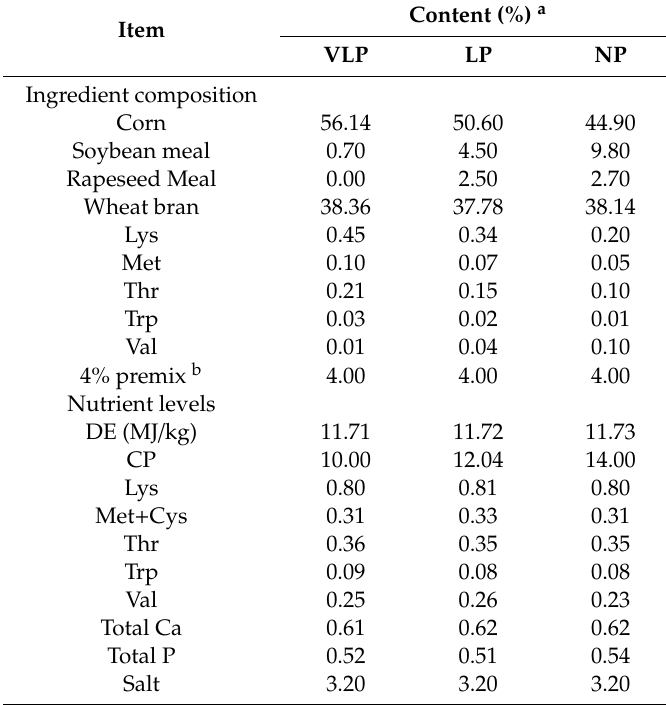
Table 1. Composition and nutrient levels of diets (DM